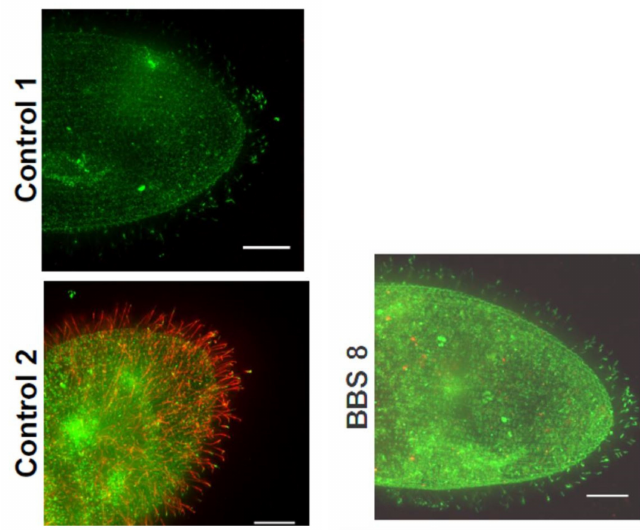
Figure 9. Immunofluorescence of FLAG-SK1a channels and folate chemoreceptor (FBP) a GPI anchored protein with antibodies against the FBP. Note that both are in the cilia, while FBP is in both the cilia and cell membrane. Only the merged images are shown here, but all controls are available [10]. FLAG control is a cell microinjected with FLAG-pPXV vector and fed RNAi empty vector bacteria. FLAG-SK1a control is a cell expressing FLAG-SK1a and fed bacteria with an RNAi empty vector. “BBS8”cells are expressing FLAG-Sk1a channel and are also depleted of BBS8 RNA by RNAi. Cells were immune stained with anti-FLAG (red) and anti-FBP (green) antibodies. These images are from a larger published study with more BBS genes silenced, and with similar results. Note that Sk1a is missing from cilia after silencing BBS8, but the FBP remains in the cilia. Reproduced from [8], with